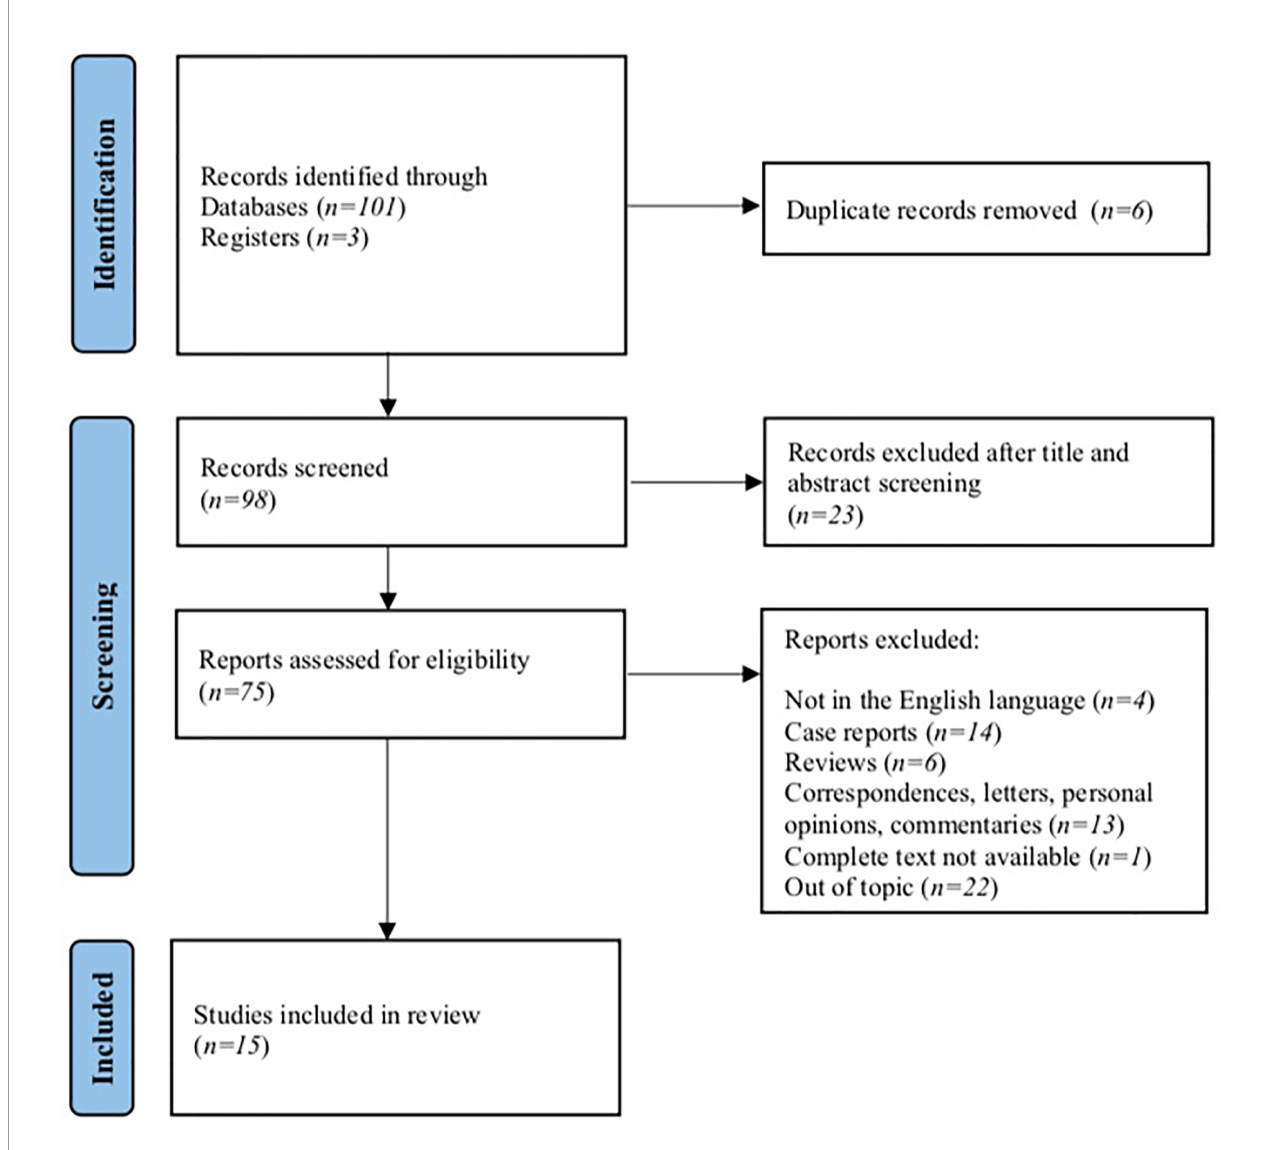
FIGURE 1 | PRISMA fl owchart for study selection of the systematic